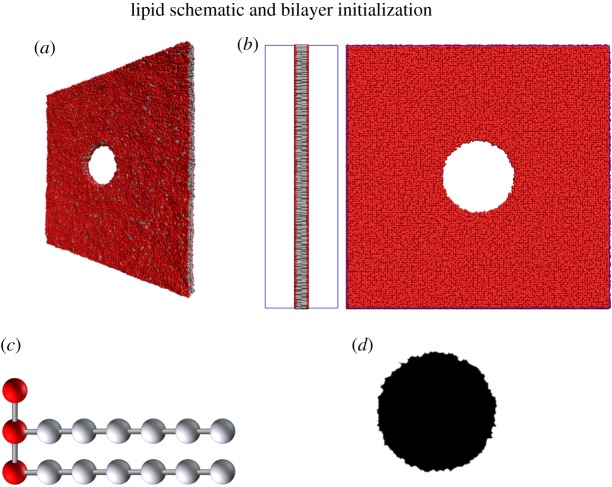
(a) Three-dimensional view of the simulated membrane with pore. Fluid particles (not shown) fill the space on both sides of the membrane and in the pore. (b) Side and front view of initial membrane configuration. Blue lines at boundary show the simulation box. (c) Lipid with three heads and two tails comprising six tail particles each. Bonds are shown as thin rods. Three-body potentials are imposed among triplets with consecutive horizontal bonds. (d) Binary matrix (value 1 shown in black) resulting from smoothing and thresholding the front view in (b).